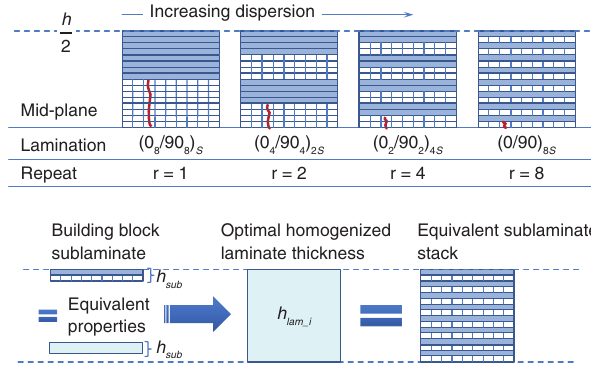
Figure 7: Representation of homogenized laminates and the dispersion of distinct fiber orientations as the repeat ‘ r ’ increases, red curves for anticipated crack stopping characteristics (top). Description of building block approach and homogenized laminate thickness